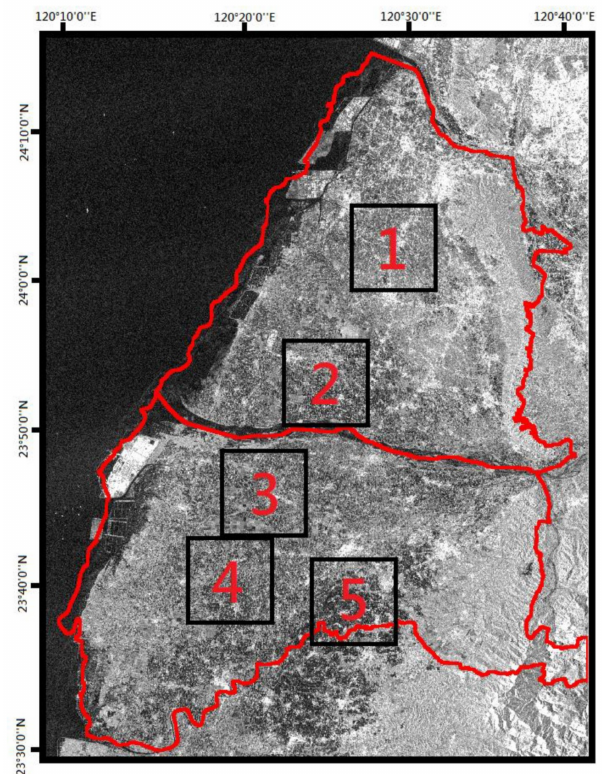
Figure 8. Five selected regions from the study